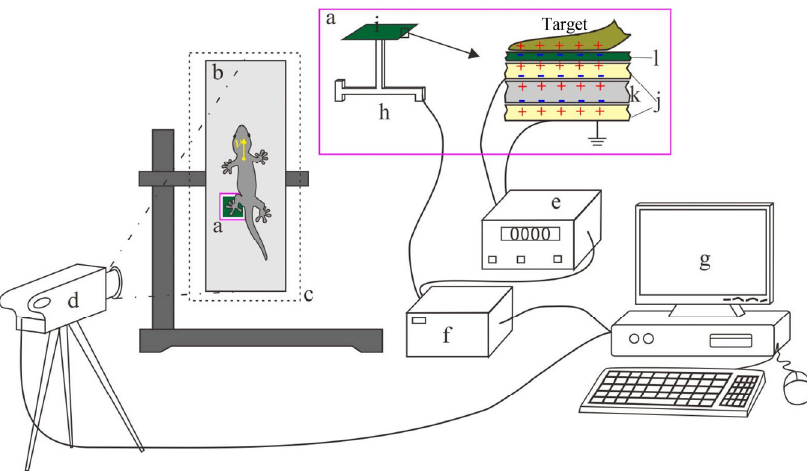
Fig. 1 Testing techniques: a—a sensor unit; b—a rotatable metal aisle; c—a metal cage; d—a high-speed camera; e—a digital coulometer; f—a NI DAQ module; g—a PC; h—a 3d force sensor; i—a charge probe; j—copper foils; k—an epoxy glass fiber plate; l—an insulator